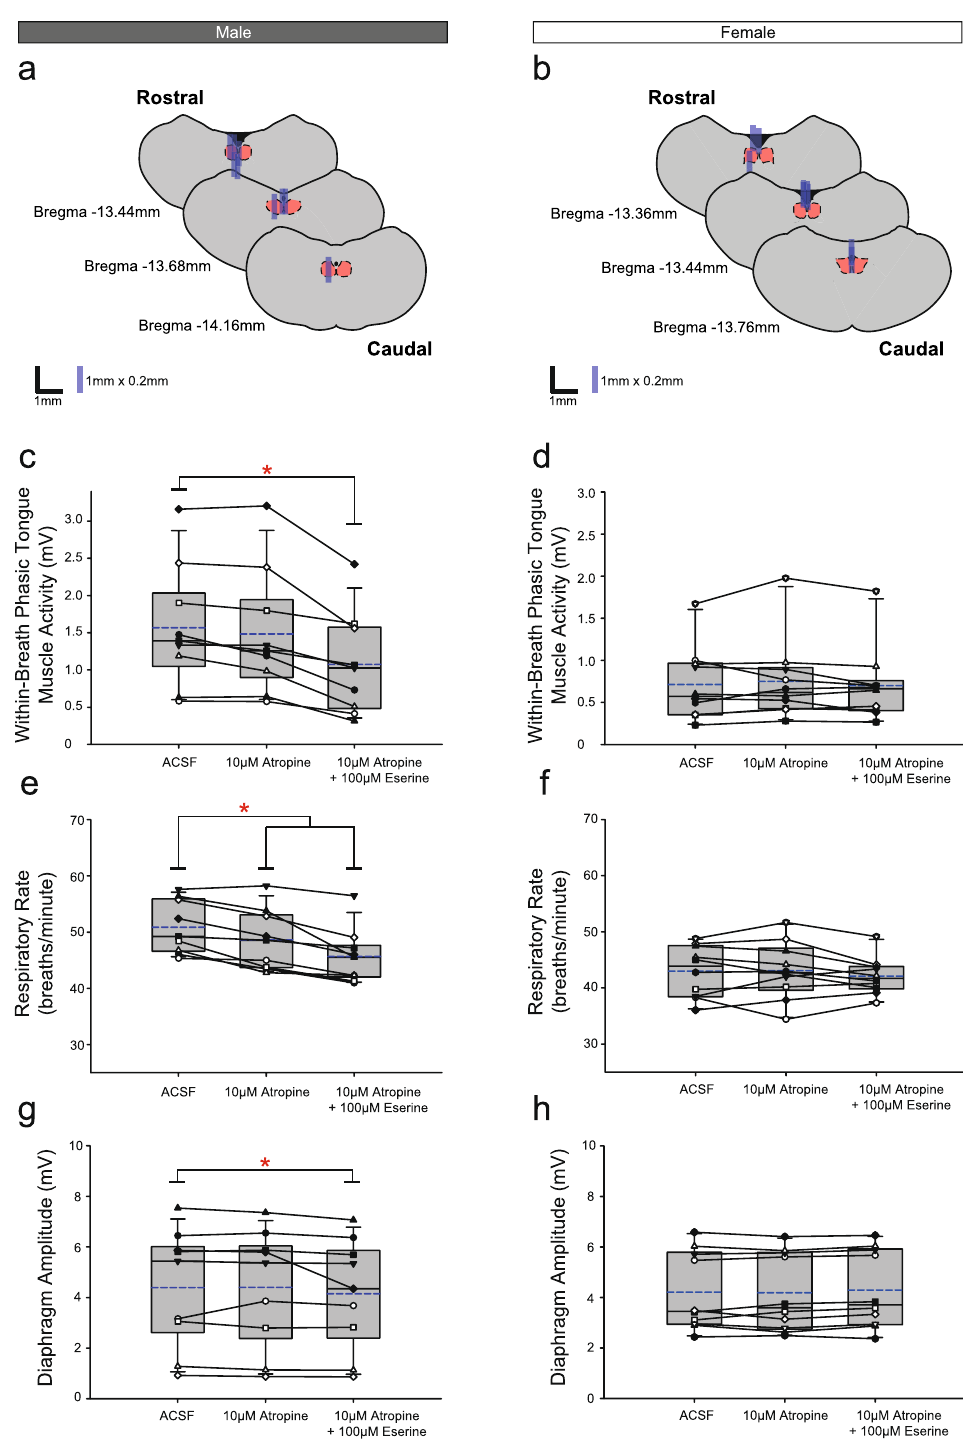
Figure 4. Group data from Protocol 1.2a : Microperfusion of 10 μM atropine into the HMN with and without co-application of eserine (left column: male, n = 9; right column: female, n = 10). Schematic representations of coronal sections of medulla illustrating the distribution of probe sites across all experiments ( a , b ). Drawn to scale, the blue rectangles represent reconstruction of the sites of the microdialysis probes; overlap obscures some of the individual probe sites. Box and whisker plots show individual and group data (median [dashed line], mean [solid line] and 25th and 75th percentiles) for within-breath phasic tongue muscle activity ( c , d ), respiratory rate ( e , f ), and diaphragm amplitude ( g , h ). Each animal is indicated by a different symbol. *, indicates p < 0.05 compared to baseline ACSF